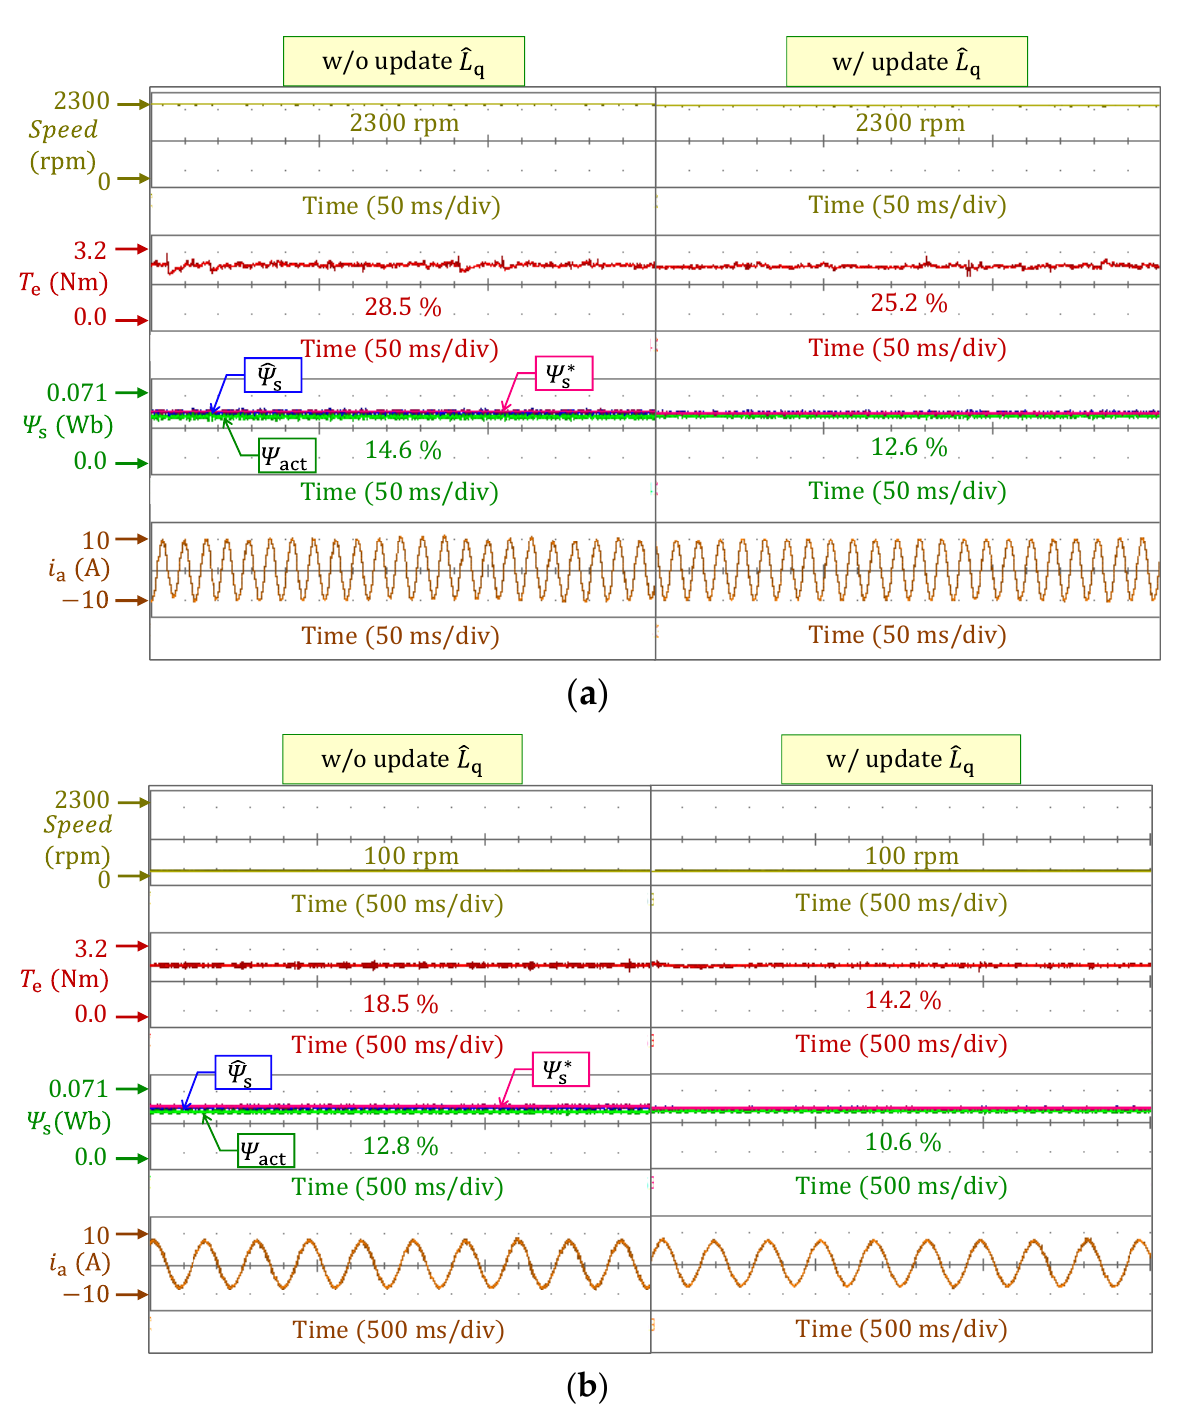
Figure 8. Comparison of speed, torque, flux linkage, current of proposed DB-CFVC between w/o and w/updated 𝐿̂ toward parameter mismatches scenario of 𝑅 s′ = 1.5𝑅 s0 , 𝐿 d′ = 0.75𝐿 d0 , and 𝐿 q′ = 0.75𝐿 q0 at ( a ) high speed (2300 rpm) and ( b ) low speed (100 rpm) under heavy load (2.5 Nm) (where 𝛹 is actual stator flux linkage) (HIL result). act